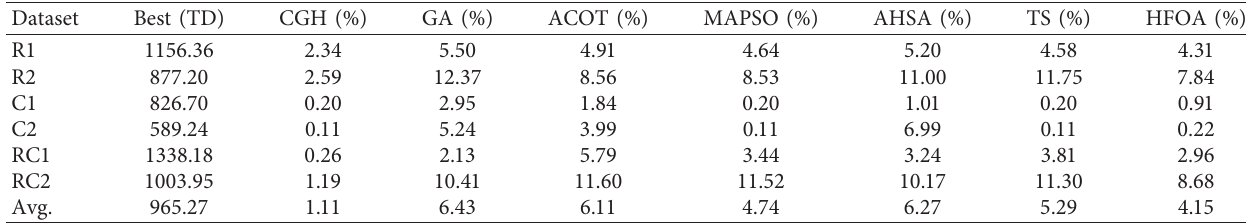
Table 6: Comparison of the HFOA with the state-of-the-art methods. Dataset